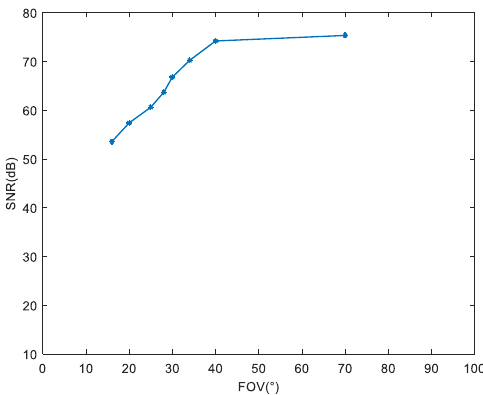
Fig. 7. The relation between the SNR and